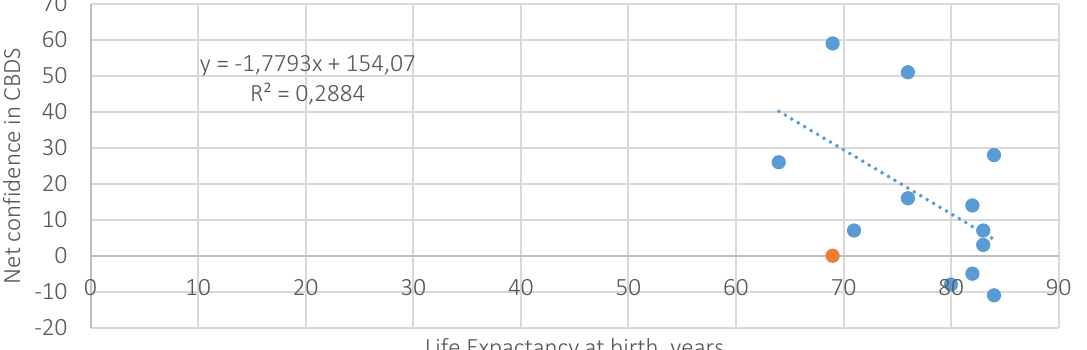
Figure Е1. Confidence in CBDS and the fraction of younger generation